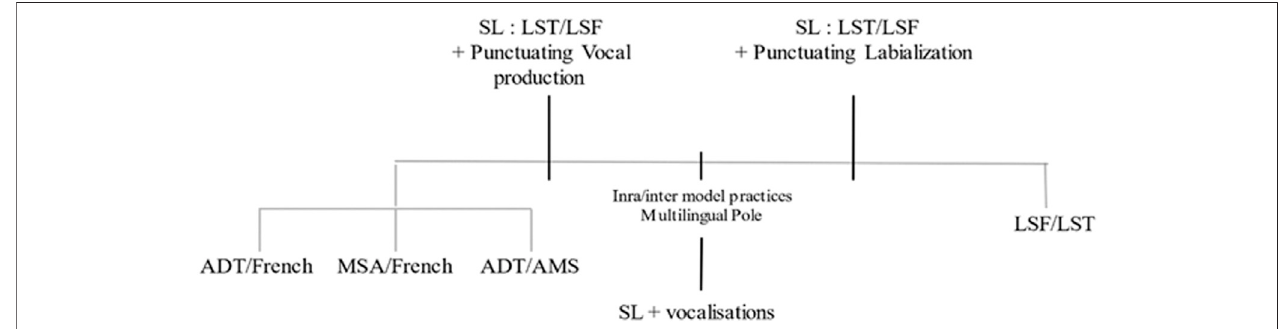
FIGURE 4 | Revised version of Khayech (2011) inter/intra model